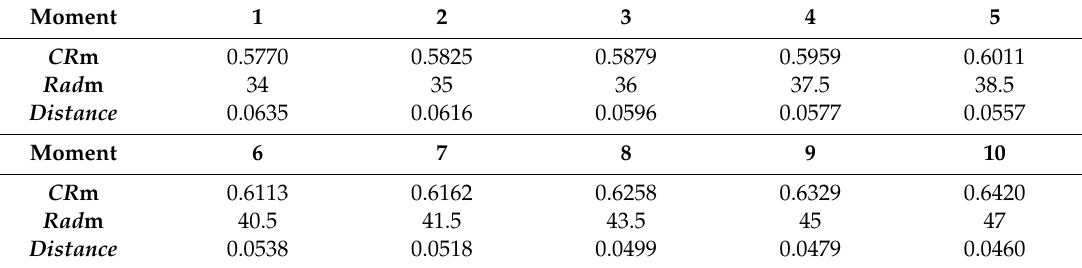
Table 1. The results calculated by the proposed model in a head-on encountering scenario. CR m: collision risk considering ship manoeuvrability, Rad m: danger sector considering ship manoeuvrability.